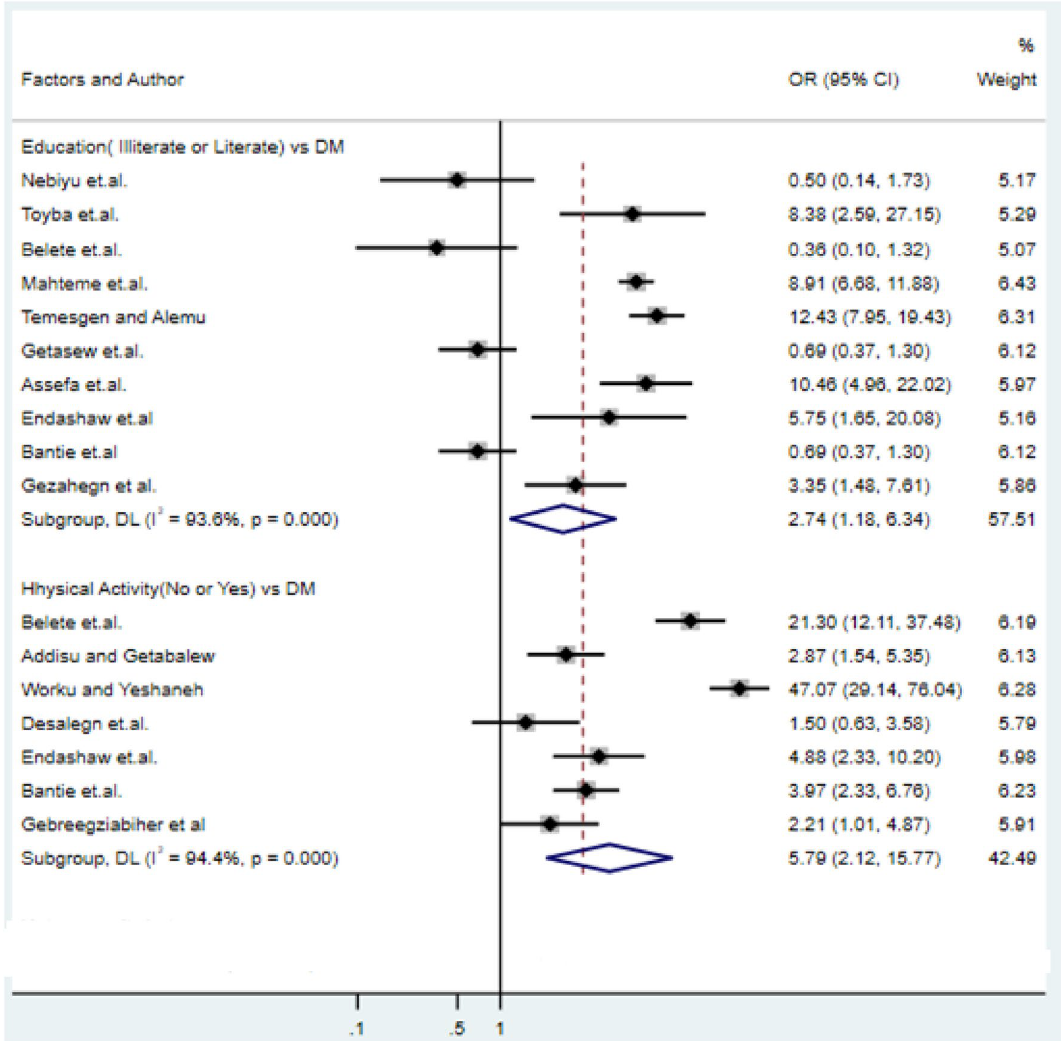
Figure 5. Forest plots of odds ratio for the association of education and physical activity with type-2